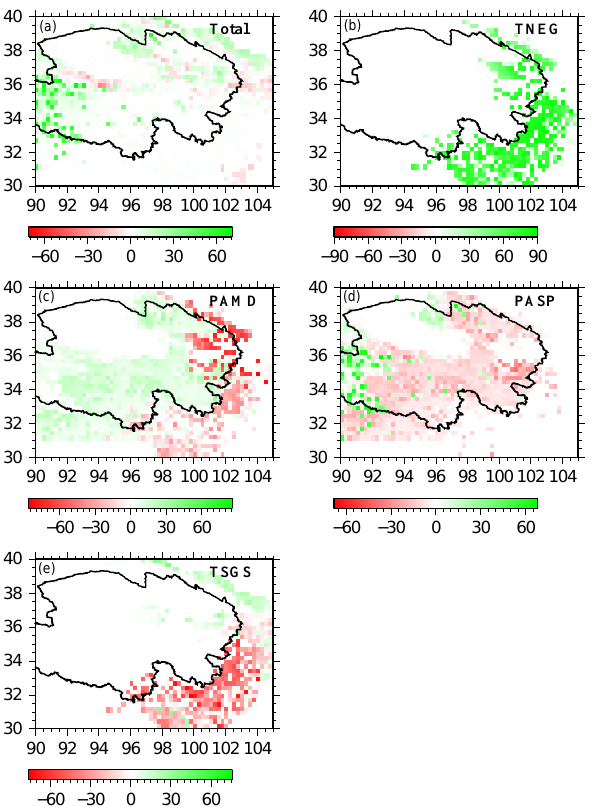
Figure 8. Elasticity of total FPC with precipitation increased by 10% (a) , air temperature increased by 1 ◦ C (b) , soil temperature increased by 1 ◦ C (c) , soil moisture increased by 10% (d) , CO 2 increased by 10% (e) , and dominant elasticity related with changes in precipitation, air temperature, soil temperature, soil moisture and CO 2 (e) . In (f) , + (plus) and (diamond) represent positive and negative elasticity, (cid:51)